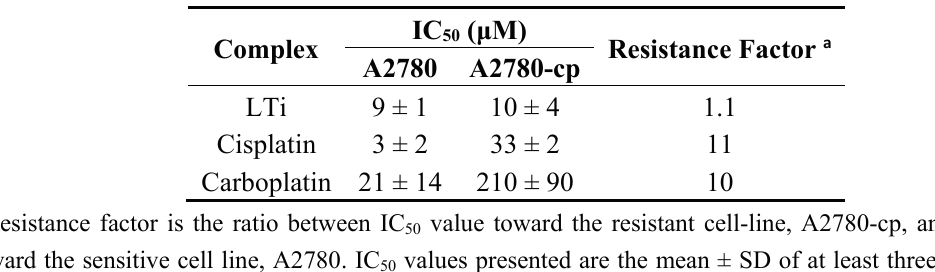
Figure 1. Dependence of cell viability on administered concentration of: ( a ) LTi, ( b ) cisplatin, and ( c ) carboplatin toward human ovarian sensitive A2780, and resistant to cisplatin A2780-cp cancer cell lines. Table 1. Relative IC 50 ( μ M) values toward human ovarian cisplatin-sensitive A2780, and -resistant A2780-cp cancer cell lines and resistance